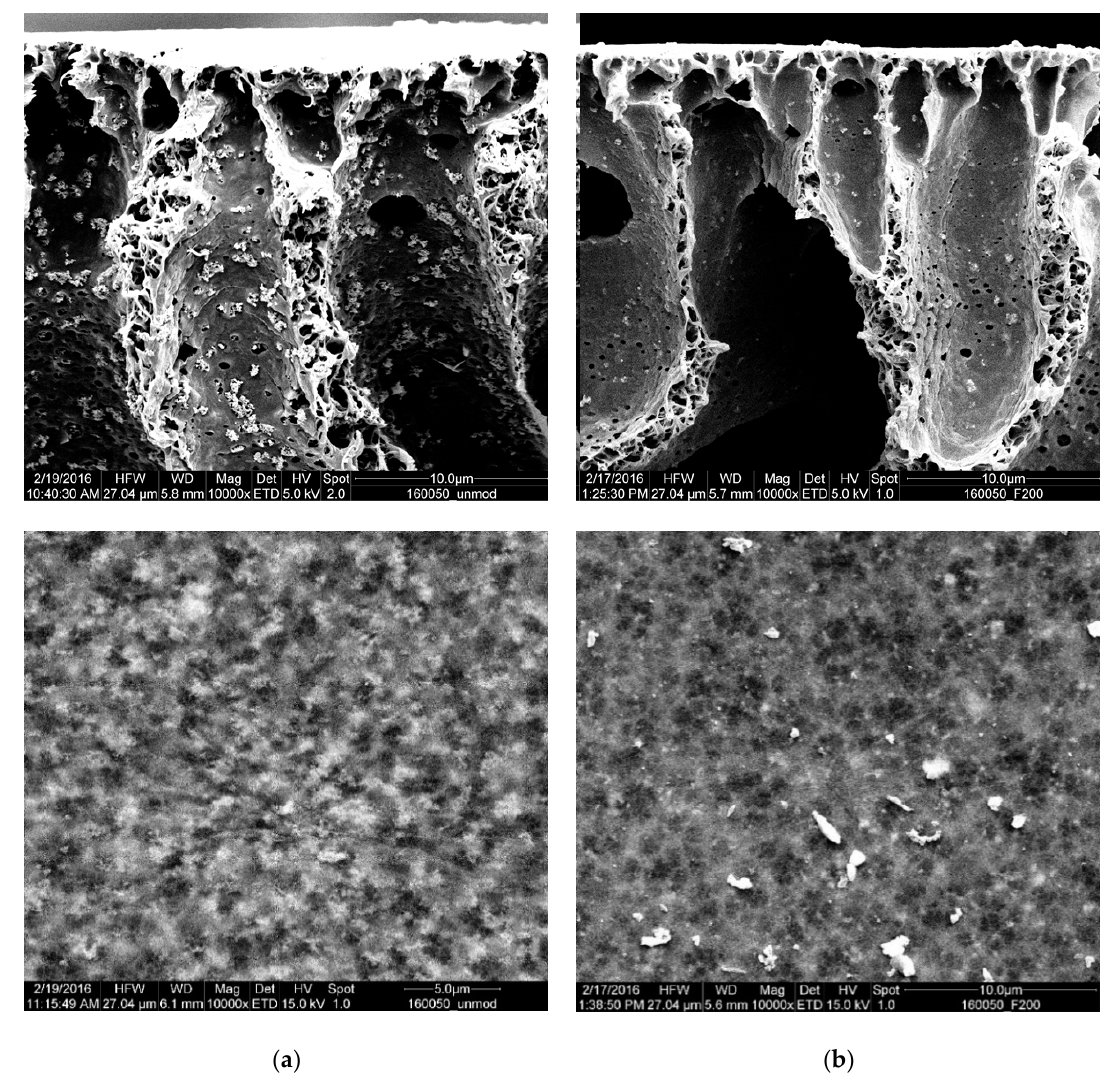
Figure 4. Nanofiller agglomerates in the cross-sections (upper pictures) and on the top layer outer membrane surface (lower pictures) of PVDF membranes obtained from dope solutions without PVP and with 50% w / w (PVDF) zinc oxide. ( a ) reference; ( b ) agglomerated; magnification 10,000 ×.